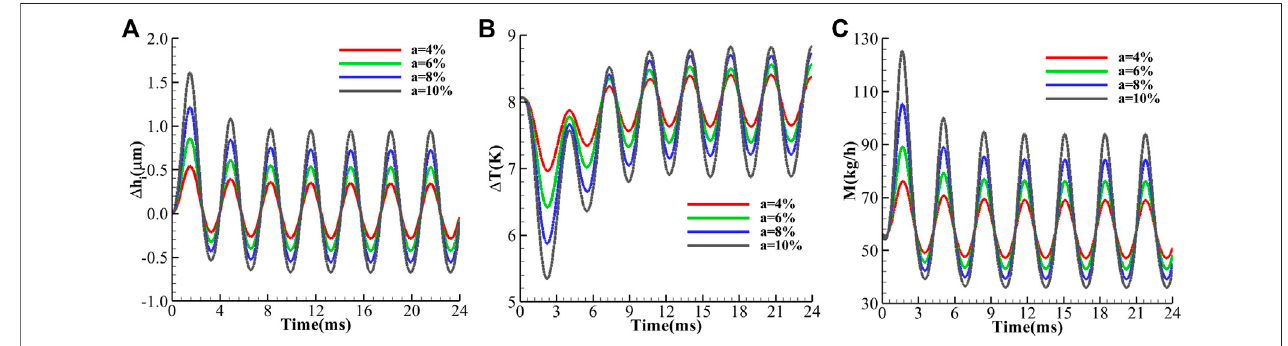
FIGURE 5 | Variation of parameters with time (A) static ring displacement, (B) inlet-to-outlet temperature difference, and (C) the